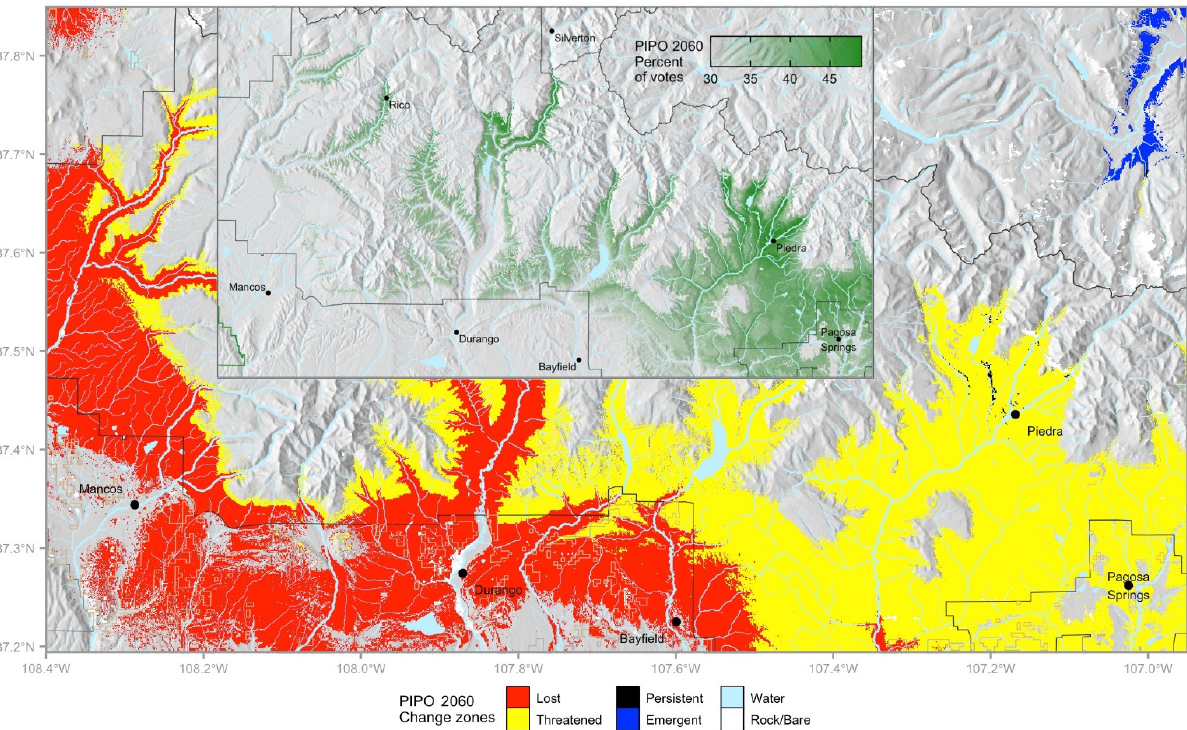
Figure 6. Change classes for Pinus ponderosa on and near the San Juan National Forest. Inset shows only threatened habitat, with color gradient representing percent of votes in the future. Deep green areas represent the most favorable of the threatened